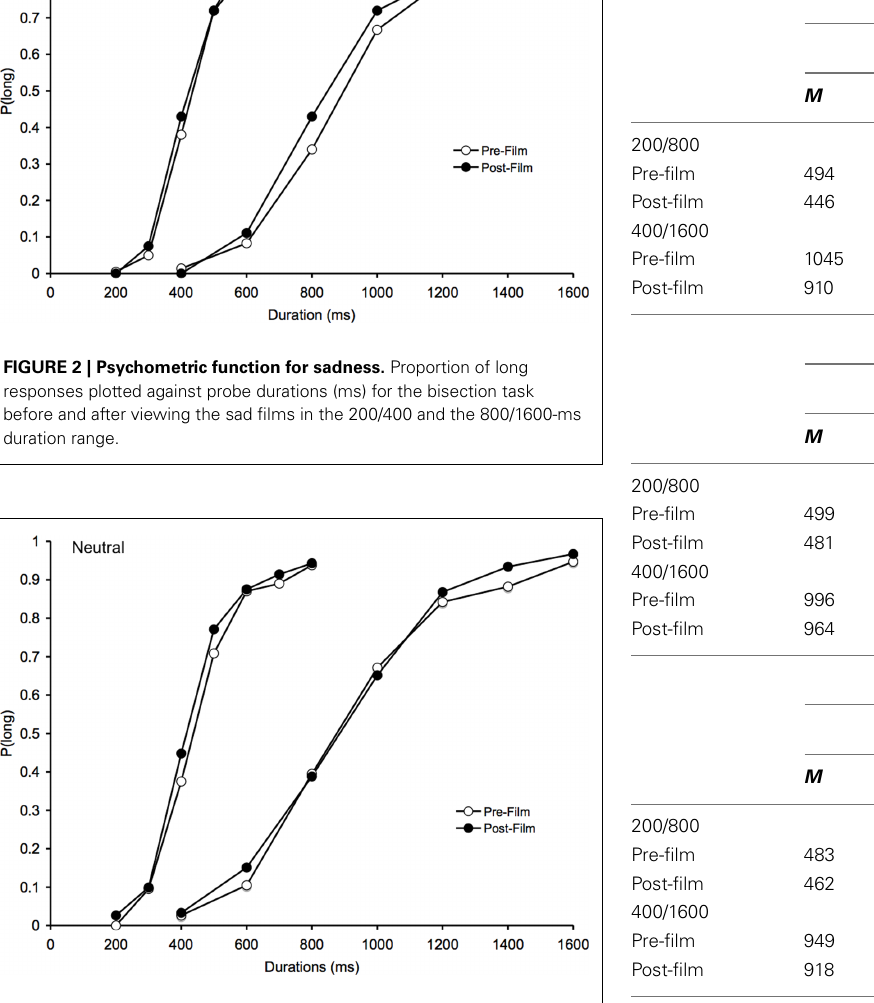
FIGURE 3 | Psychometric function for neutral. Proportion of long responses plotted against comparison durations (ms) for the bisection task before and after viewing the neutral films in the 200/400 and the 800/1600-ms duration range.